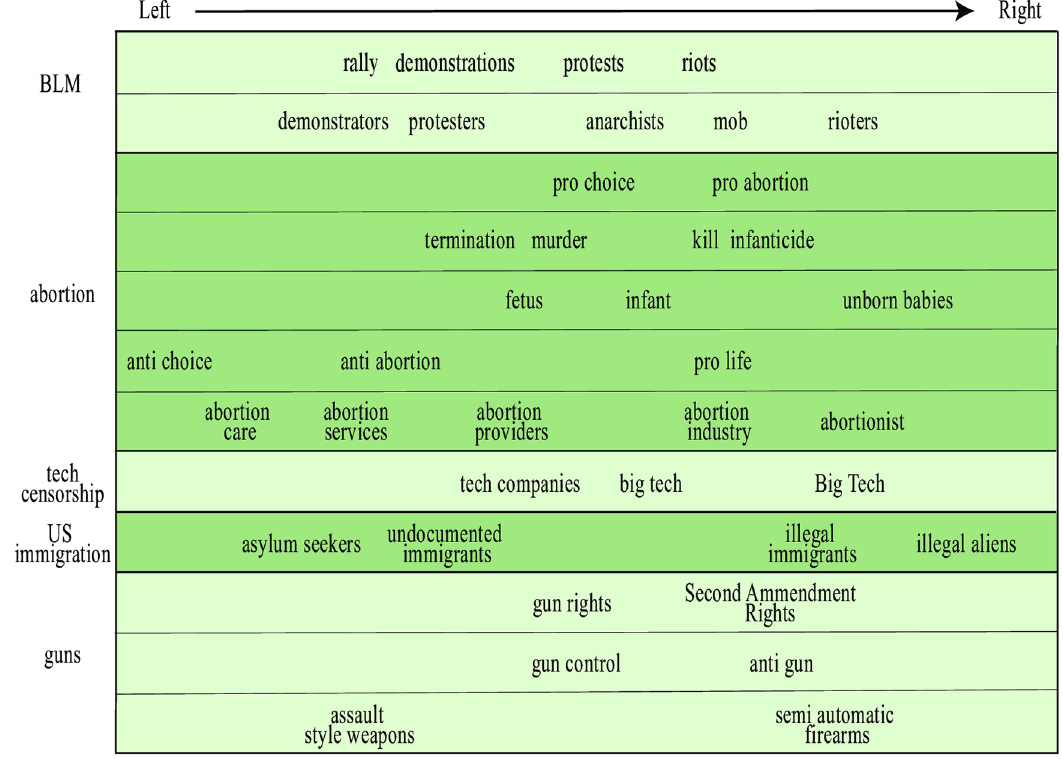
Fig 3. Valent synonyms reflecting left-right bias. Each row shows phrases that can be used rather interchangeably, with a horizontal position reflecting where our automated algorithm placed them on the left-right bias axis.